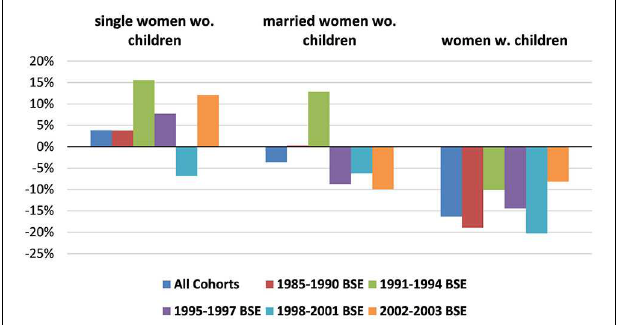
FIGURE 6 | Gender gap in retention in engineering by family-status of women at 7–8 years post-BSE for all BSEs (comparison group: all men). Data Source: NSF SESTAT Surveys 1993–2010.